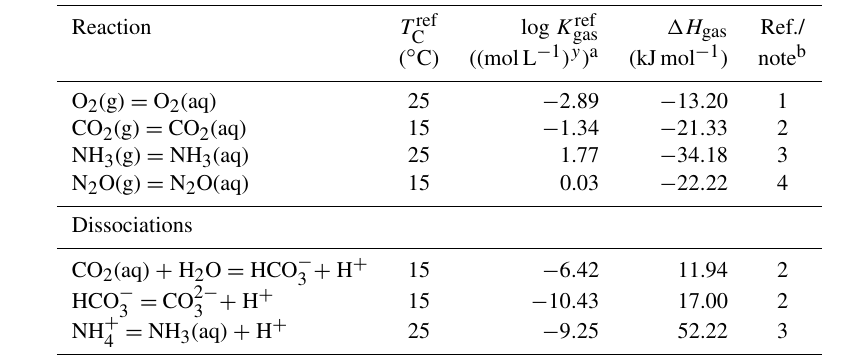
Table 4. Thermodynamic data for gaseous species a . Reaction T ref